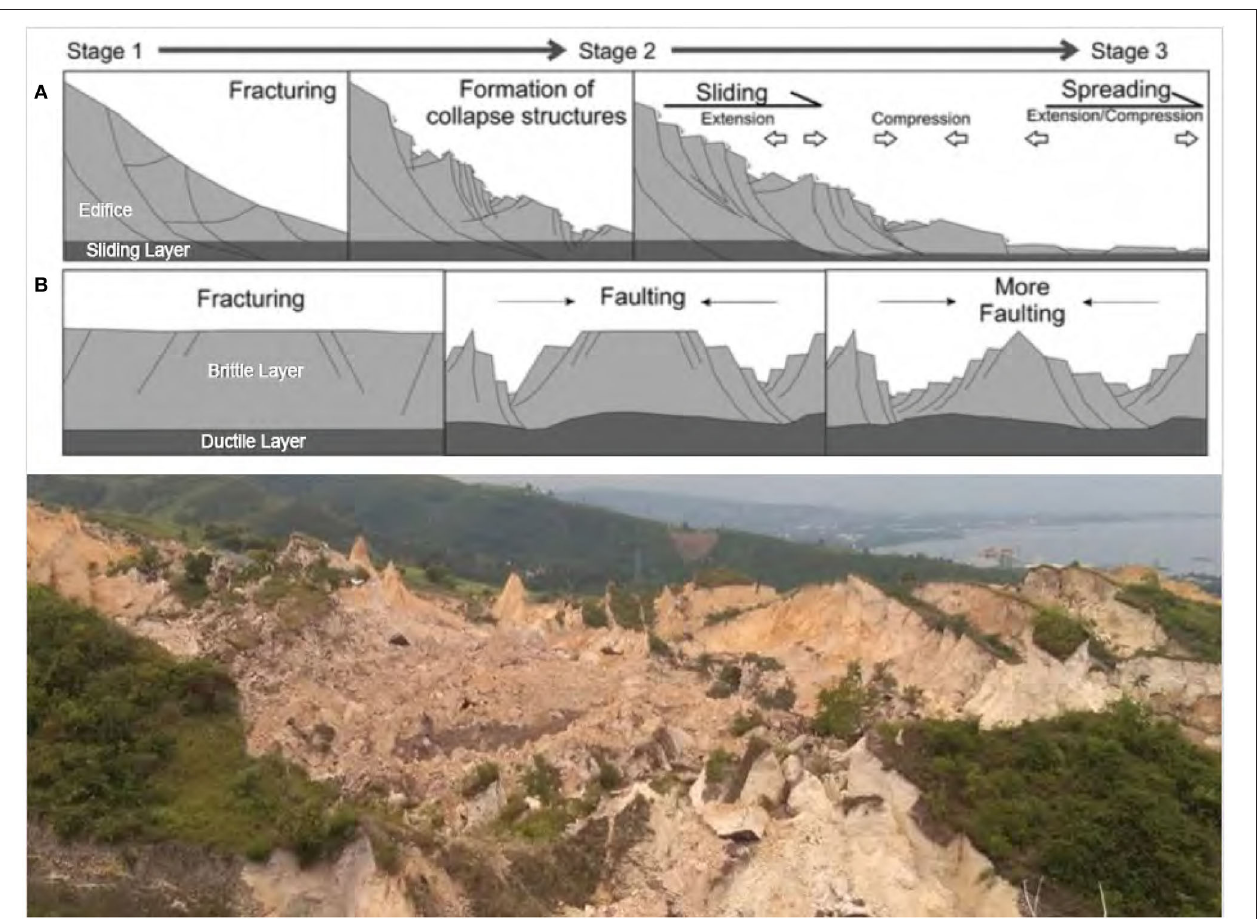
Frontiers in Earth Science |